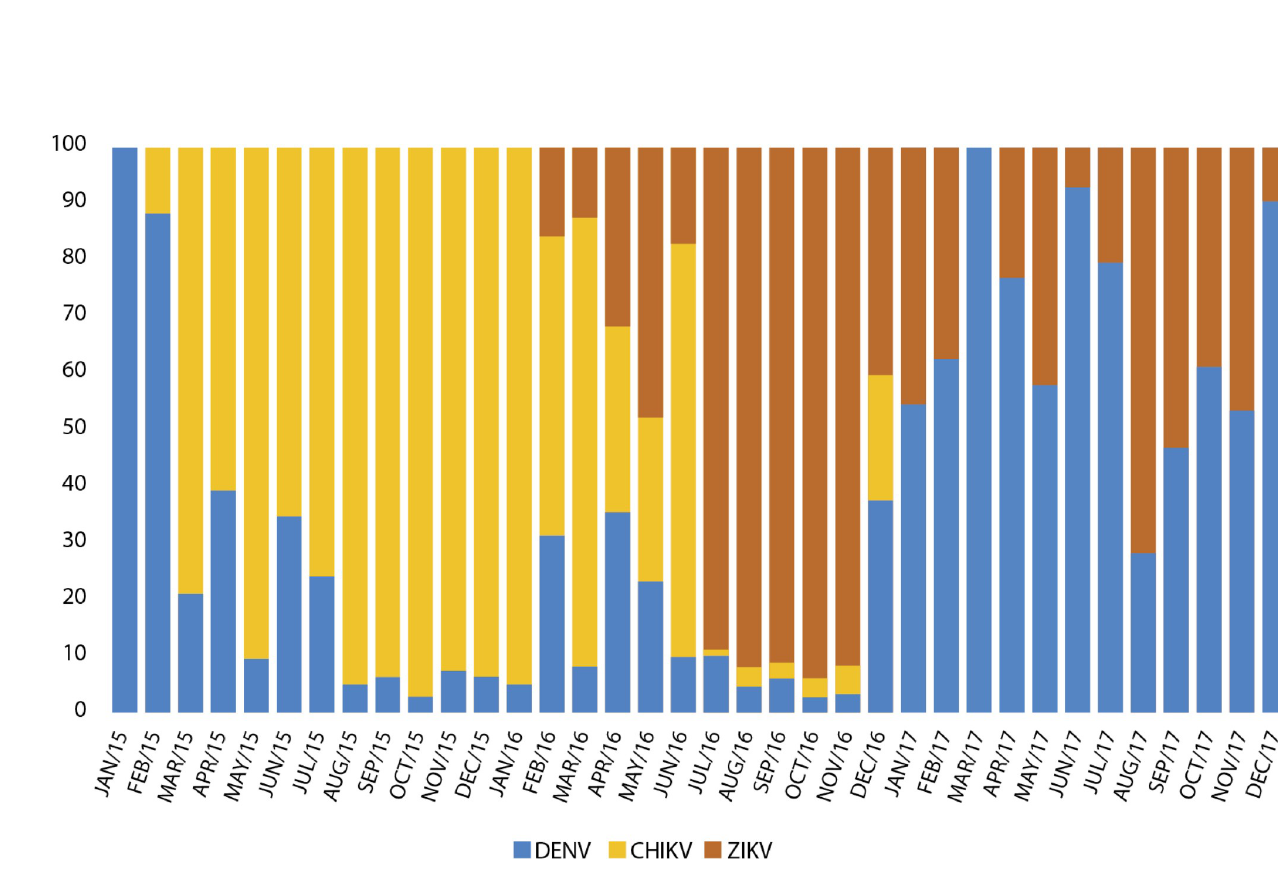
PLOS NeglectedTropical Diseases | https://doi.org/10.1371/journal.pntd.0009922 December2, 2021 10 /